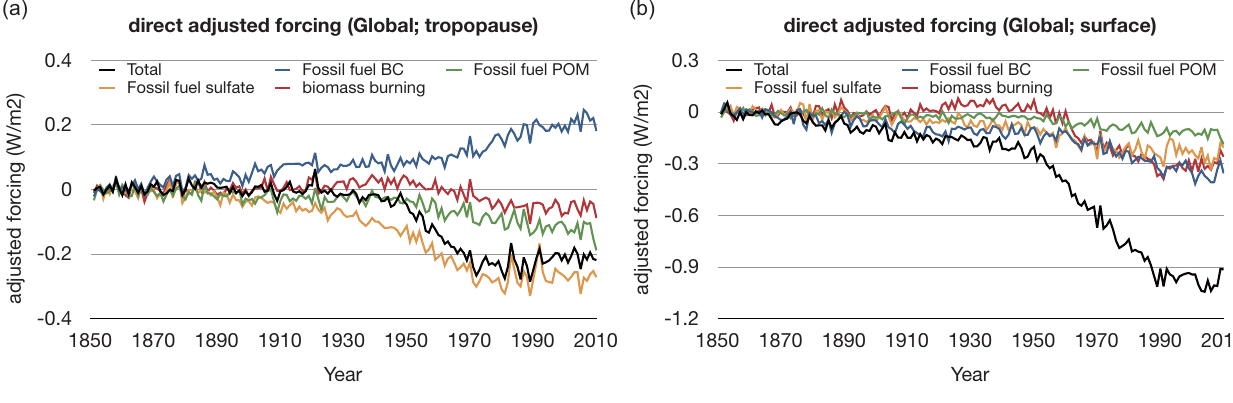
Fig. 11. Time series of annual and global mean adjusted forcing due to the direct effect by aerosols from fossil fuel (BC, POM, and sulphate) and from biomass burning at the (a) tropopause and (b) surface relative to the preindustrial experiment simulated by